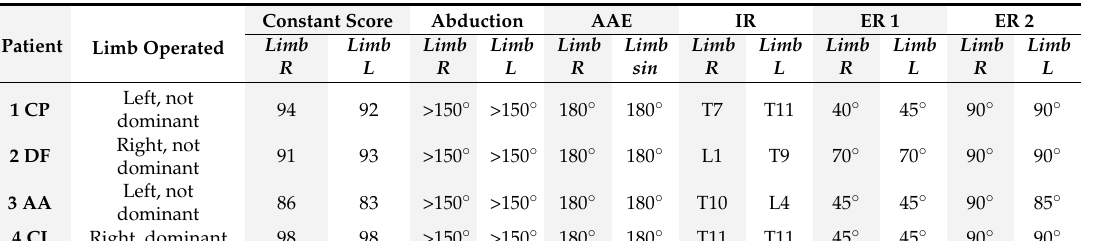
Figure 3. ( A ) Intra rotation at the Th10- level for both arms; ( B ) active anterior elevation (AAE) 180°; ( C ) extra rotation and abduction. Table 2. Constant shoulder score results in 2010. R: right; L: left; AAE: active anterior elevation; IR intrarotation; ER 1 extrarotation and adduction; ER 2 extrarotation and abduction.